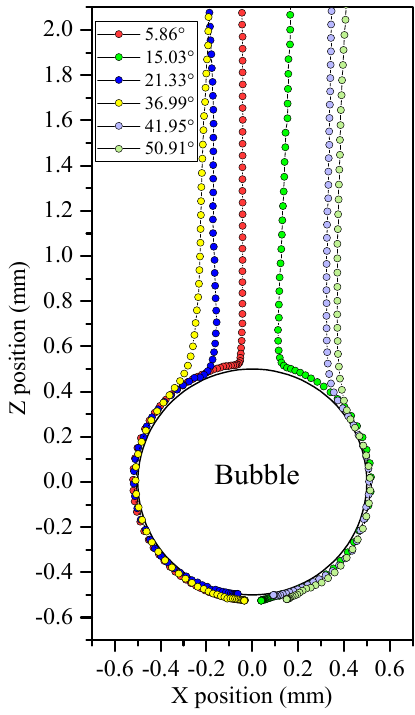
Figure 8. Trajectory of coal particles.